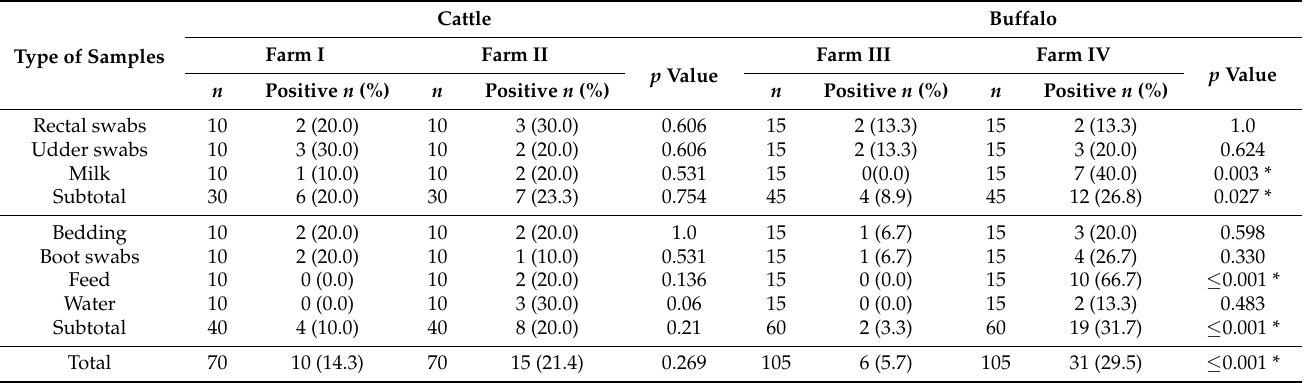
Table 2. Distribution of S. aureus among different samples isolated from cattle and buffalo farms through detection of the nuc